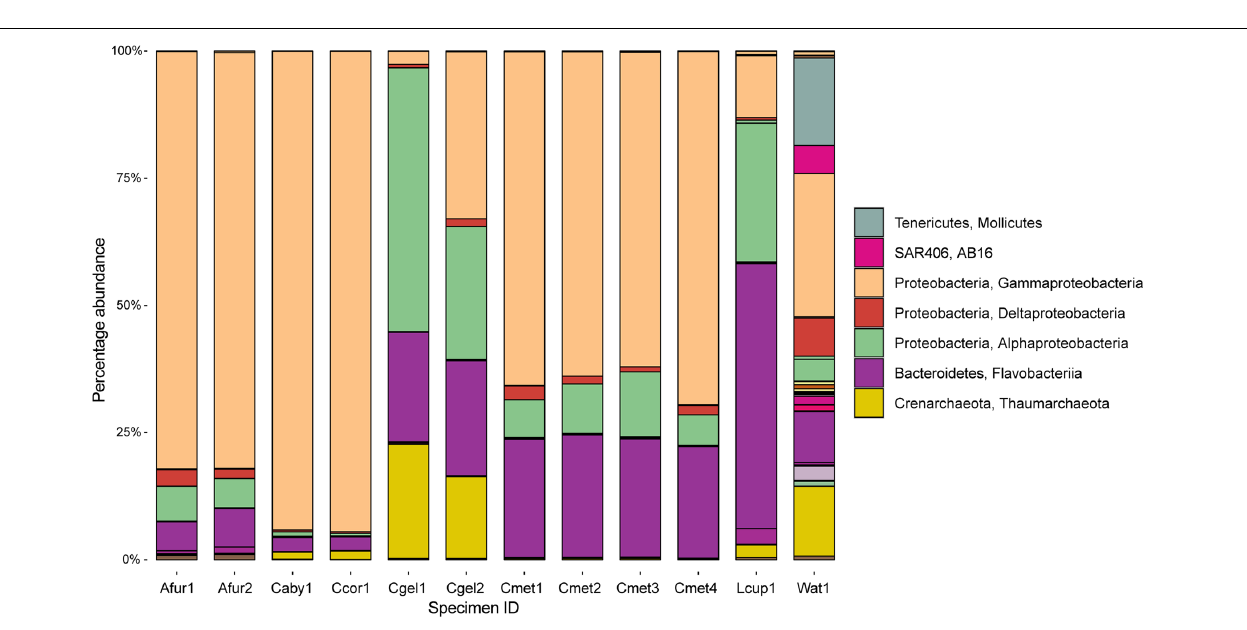
FIGURE 6 | Abundance at the class level across sampled cladorhizids and Troll Wall water sample. Major classes are indicated in the legend.